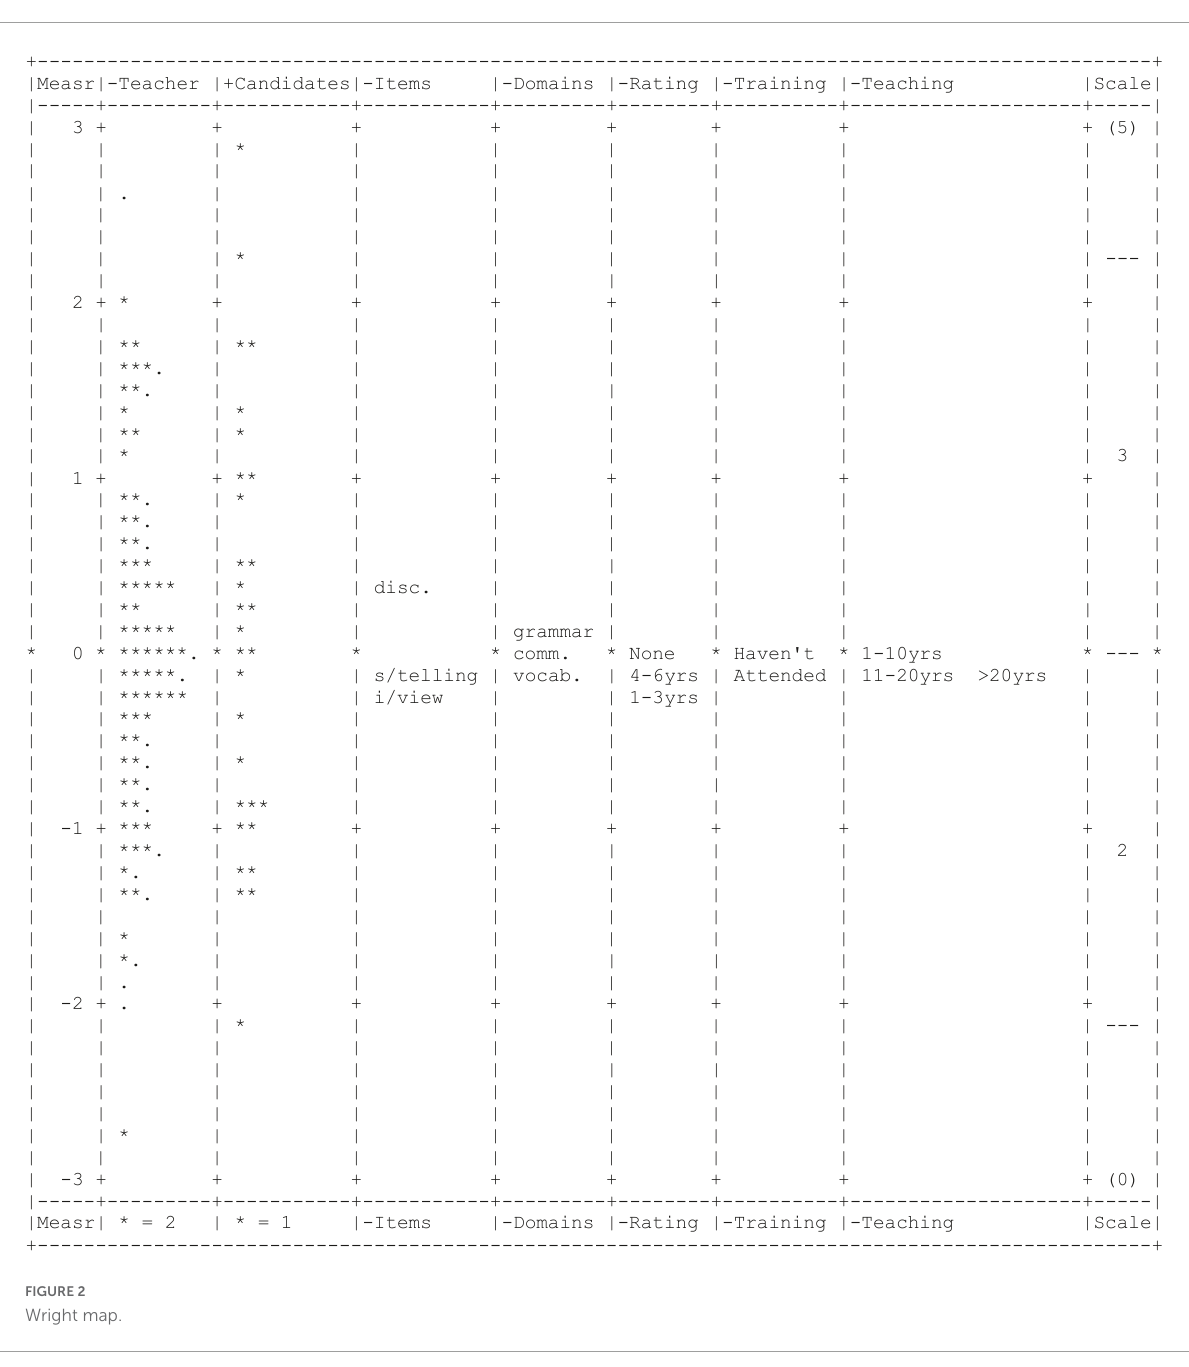
TABLE 6 Teachers’ differences in severity based on rating